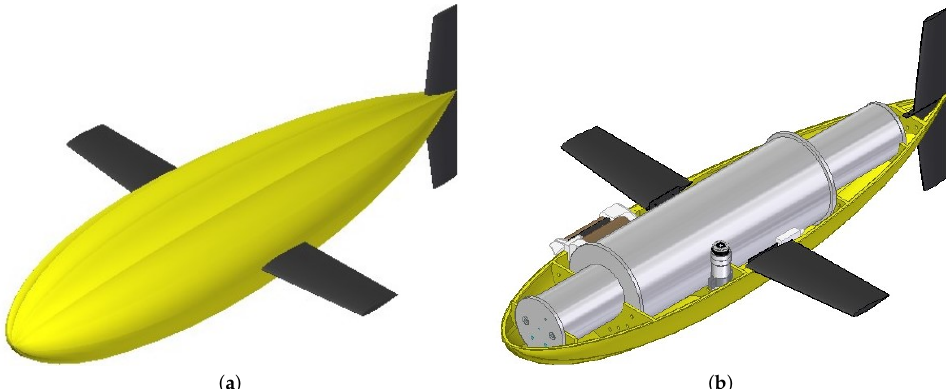
Figure 11. Bioinspired glider layout. ( a ) External layout. ( b ) General layout.